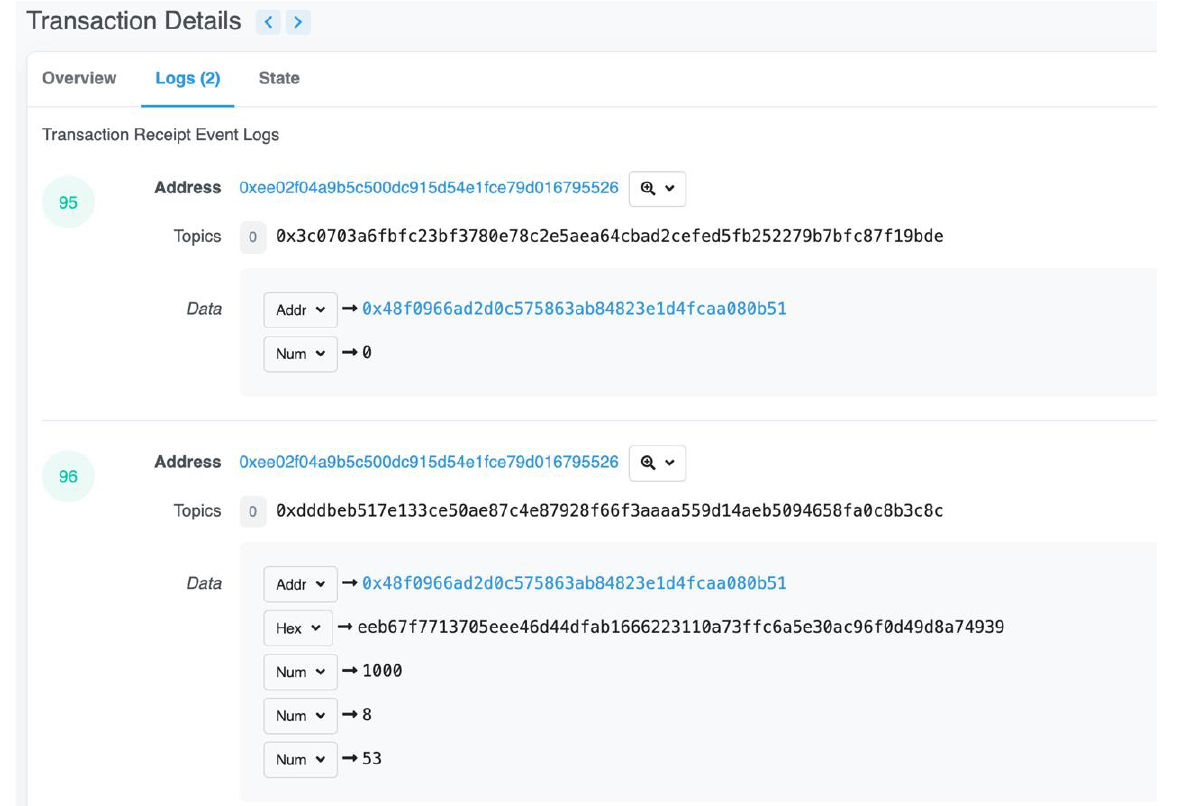
Figure A12. Logs of issuing funding request transaction.